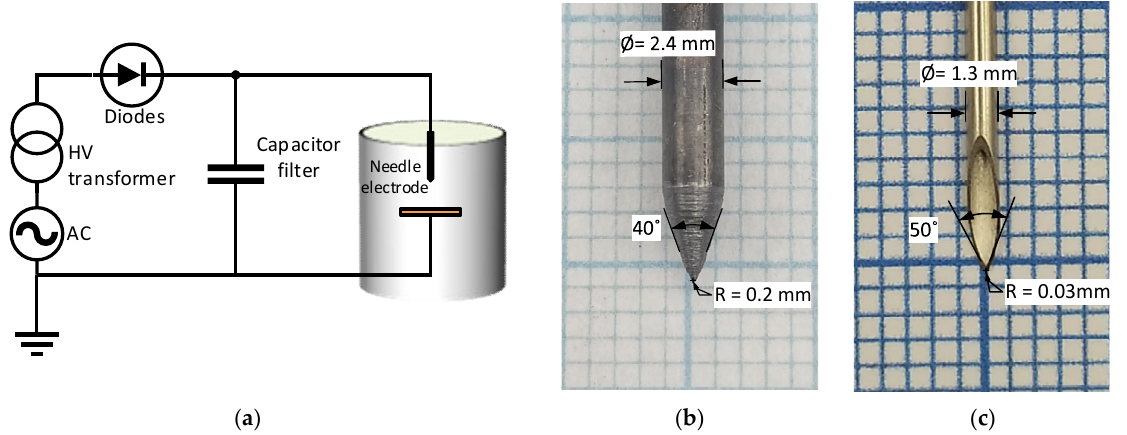
Figure 3. ( a ) Sketch of the experimental setup with the AC programmable power supply, the high- voltage transformer, the diode rectifier, the capacitor filter, and the needle-to-plane gap. ( b ) Detail of Electrode #1. ( c ) Detail of the Electrode #2.